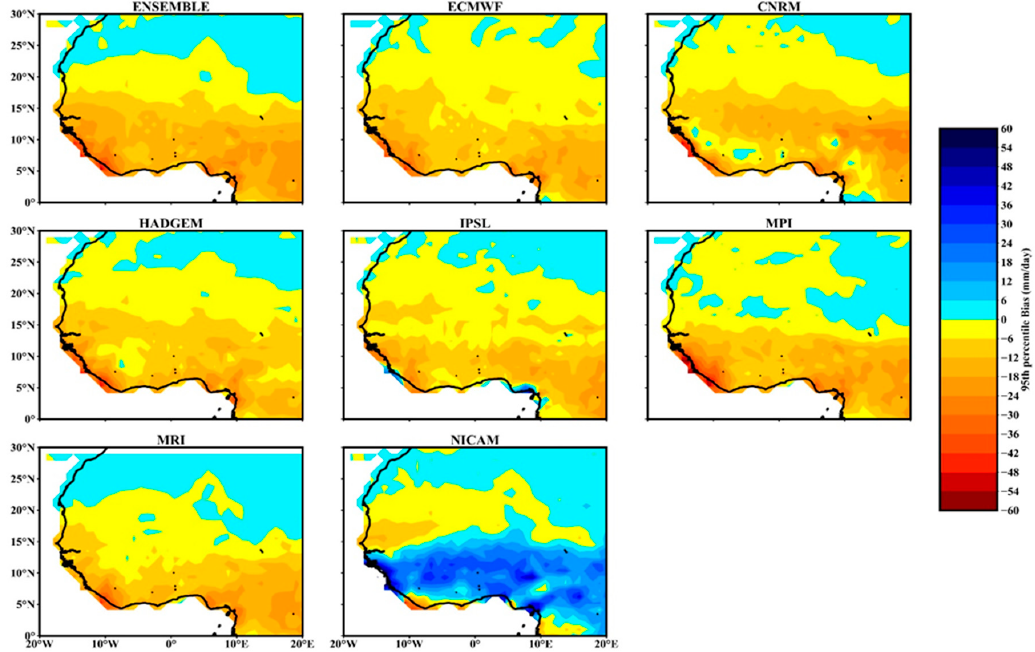
Figure 8. The spatial pattern of mean bias of 95th percentile precipitation with respect to GPCC data.